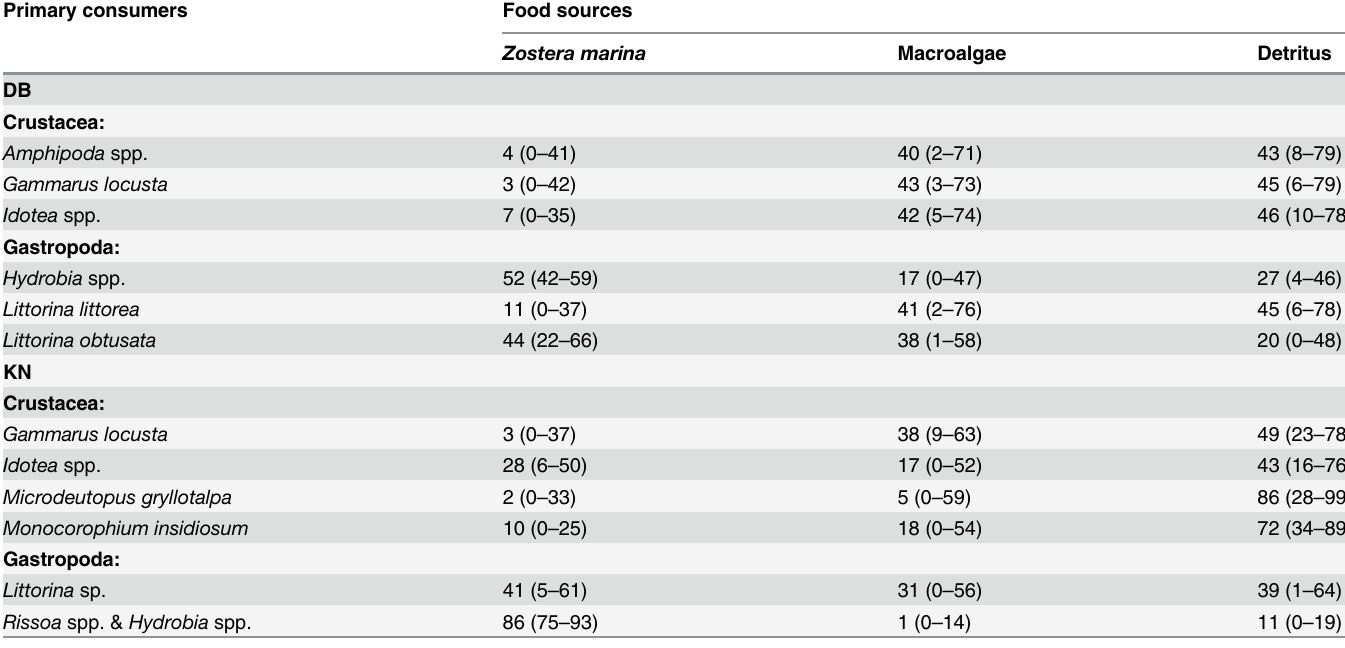
Table 4. Proportional (%) contribution of primary production food sources to selected benthic invertebrates in DB and KN in June 2011. Primary consumers Food sources